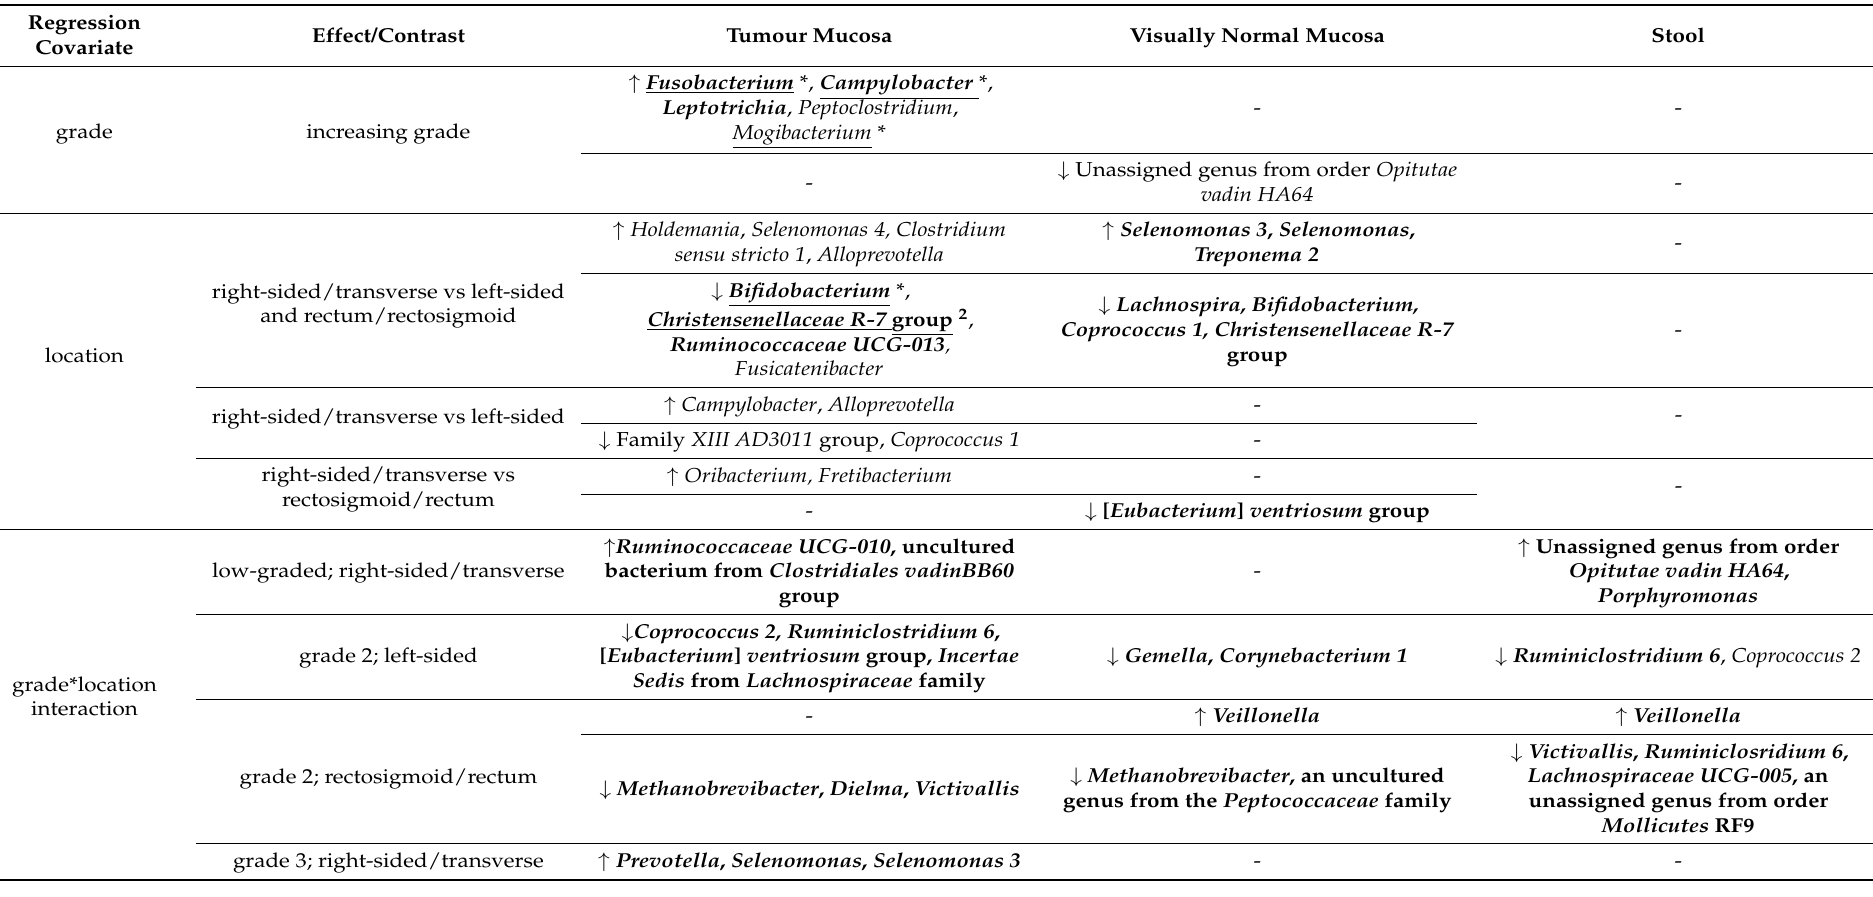
Table 2. Summary of rank regression results ( p < 0.05) associating microbiome of the three different sample types with the clinical variables. Bold text denotes genera significant at FDR < 0.1, text underlined by a solid line denotes that the association was validated in an independent dataset, marked by the superscript number ( 1 Feng et al. [30]; 2 Dejea et al. [31], * previously published association [40,66,68–72], see Discussion and Table S11). Up and down arrows denote increase or decrease in abundance,